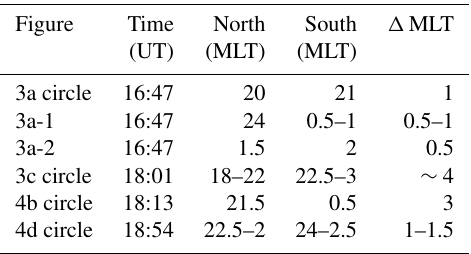
Table 1. Summary of asymmetric features identified in Figs. 3 and